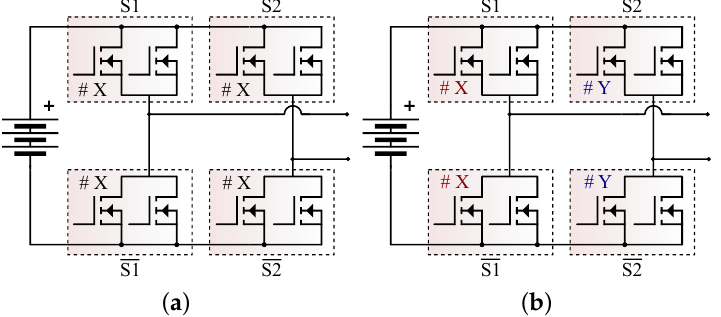
Figure 8. Inverter part number configuration for PS. ( a ) Scenario where all MOSFETs have the same part number. ( b ) Scenario using two different part numbers.